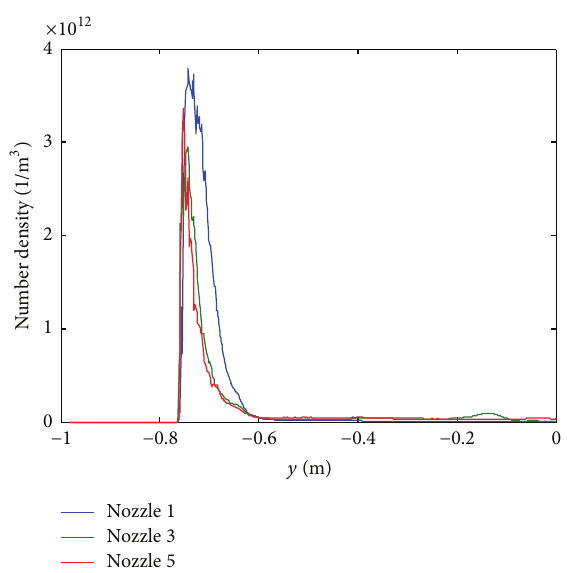
Figure 14: Plot of the number density of bin fraction